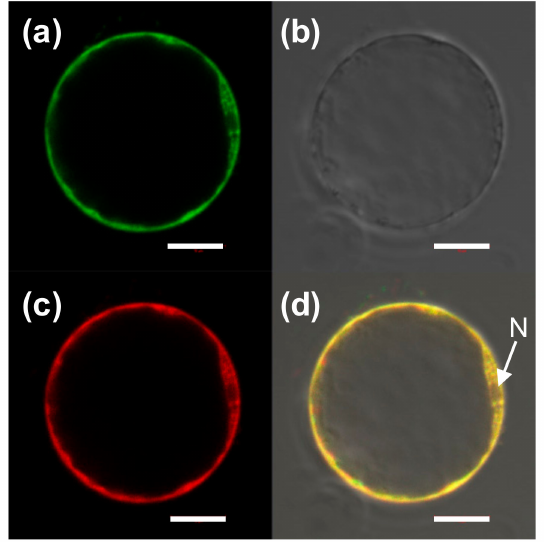
Figure 7. Subcellular localization of OsAAA-ATPase1 in rice protoplasts. ( a ) EGFP-OsAAA-ATPase1, ( b ) blight field image, ( c ) mCherry (cytoplasmic localization), and ( d ) combined image of ( a – c ). N, nucleus; bar, 20 µ